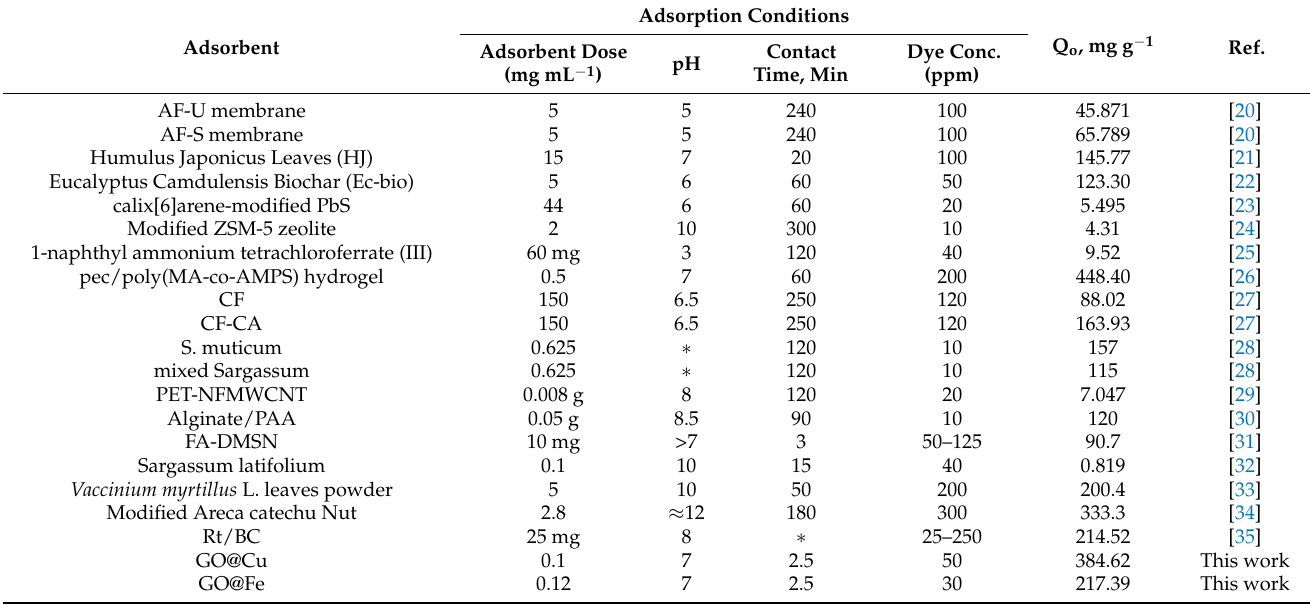
Table 5. Comparison of various adsorbents for removal of